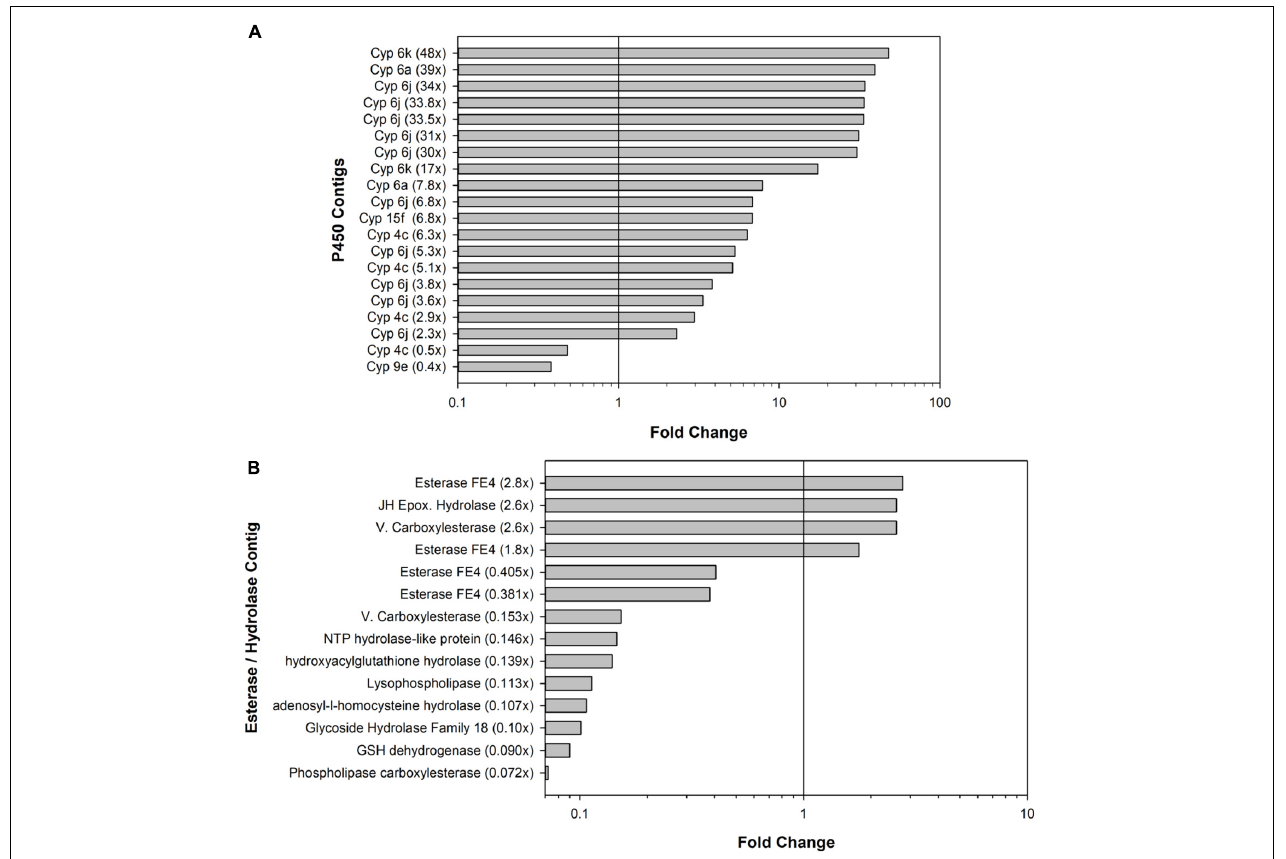
FIGURE 3 | Bar graphs showing the numbers of significant differentially expressed contigs. (A) Cytochrome P450 (Cyp) contigs and (B) esterase and hydrolase contigs. Bars to the right of vertical black lines indicate upregulated contigs; bars to the left indicate downregulated contigs.